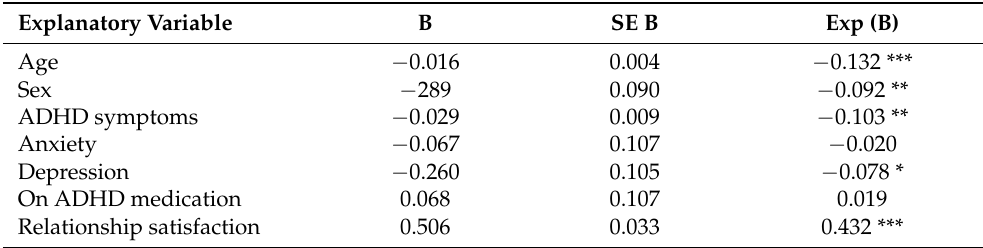
Table 5. Summary of the final hierarchical regression analysis model for variables predicting sexual satisfaction ( n = 963).